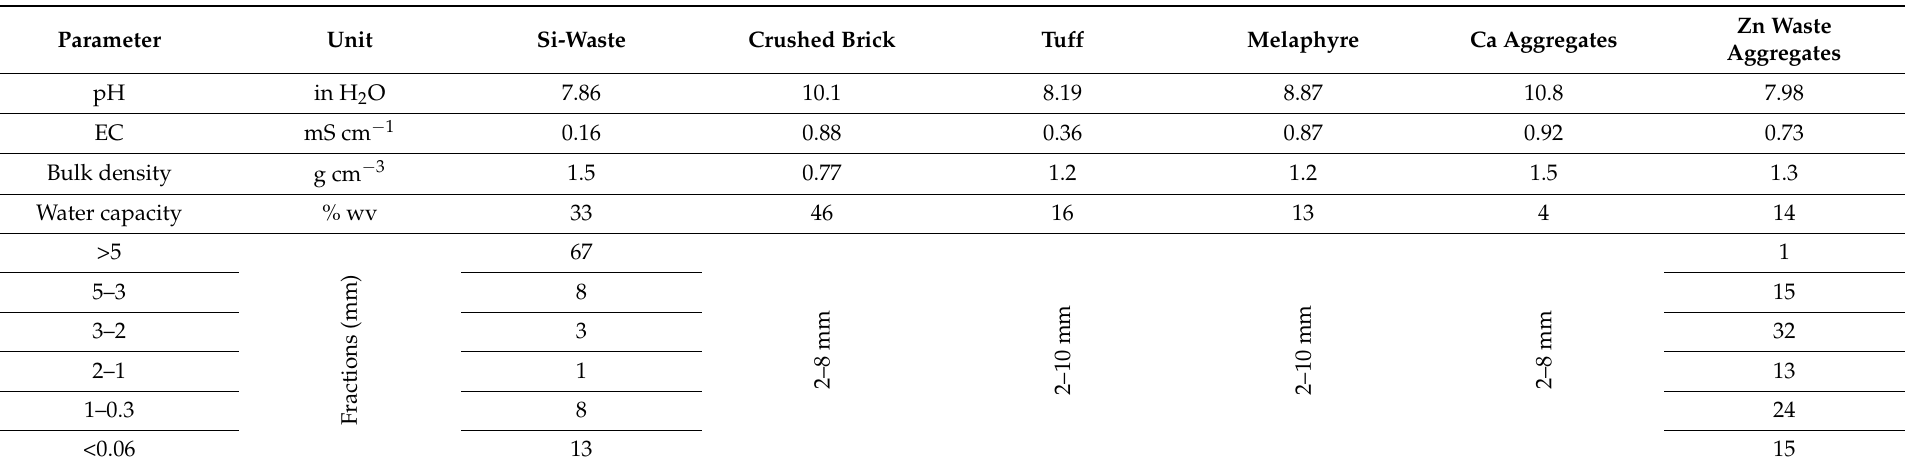
Table 2. Properties of mineral components used in the experiment.